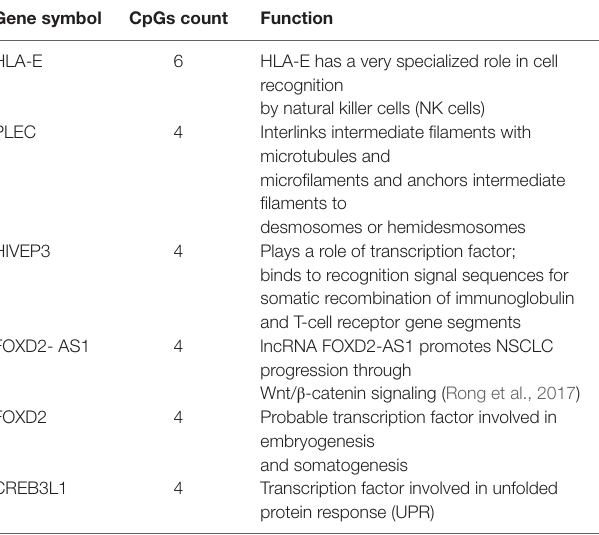
TABLE 3 | Top enriched genes and